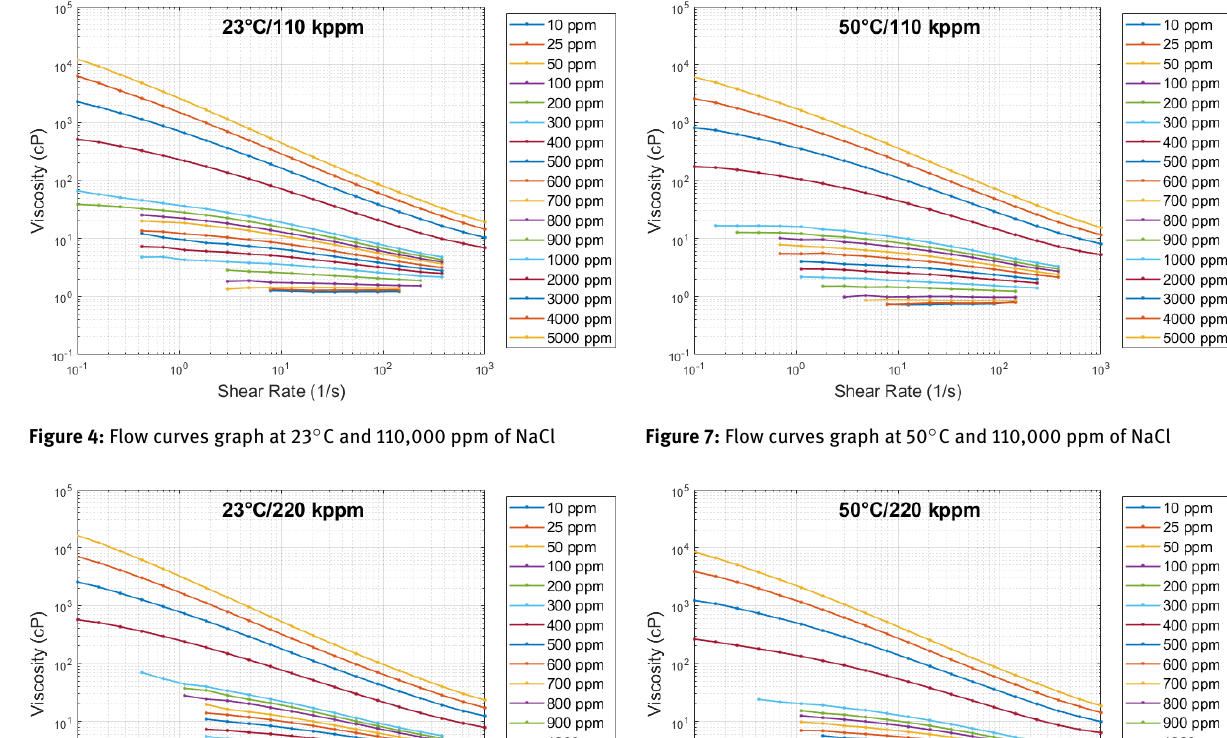
Figure 3: Flow curves graph at 23 ∘ C and 20,000 ppm of NaCl